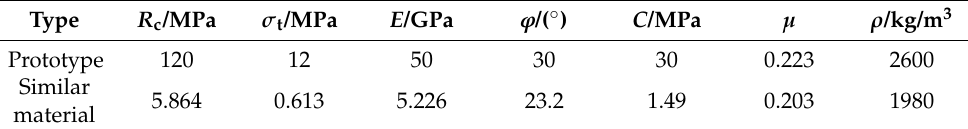
Table 1. Physical and mechanical parameters of similar materials and the prototype of the intact